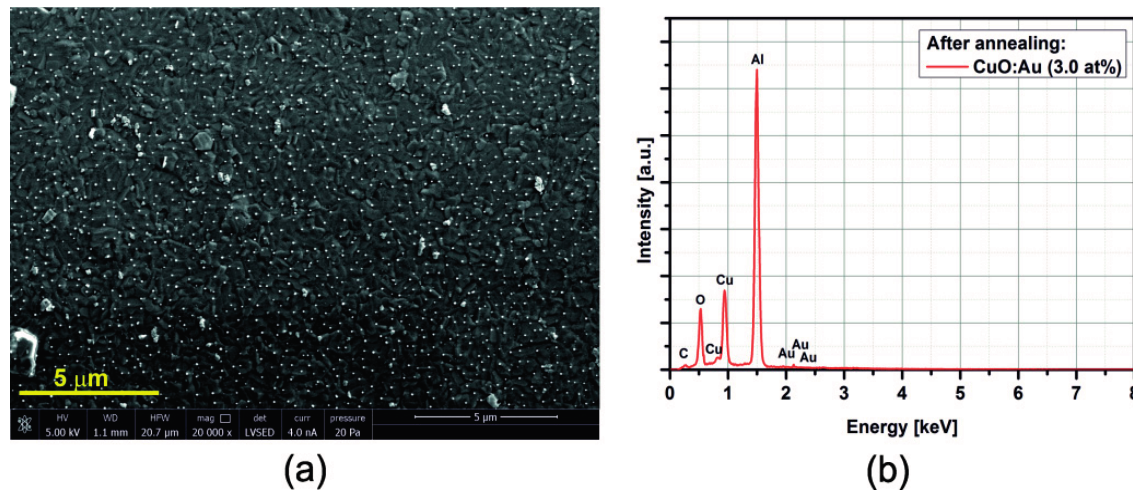
Figure 5. ( a ) SEM image; ( b ) EDX distribution of the Ag:CuO-based sensor (Ag: 1.0at%).